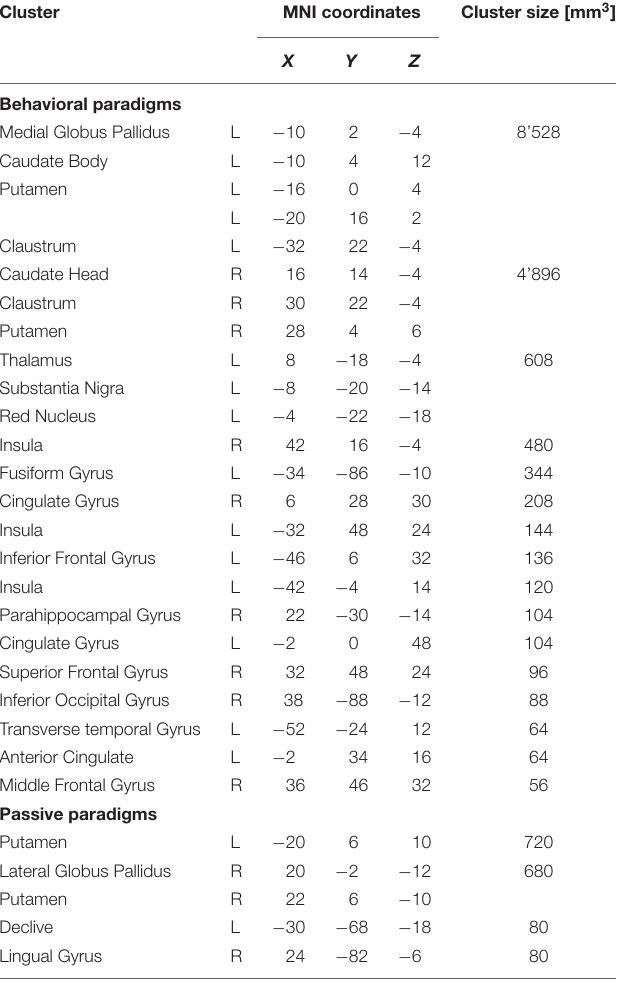
TABLE 3 | Details of the clusters revealed by the analyses of the behavioral and passive studies. Cluster MNI